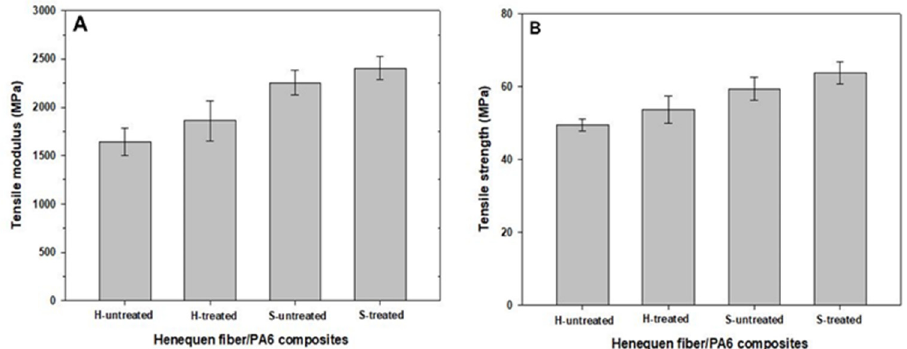
Figure 9. Tensile modulus ( A ) and strength ( B ) of untreated and alkali-treated henequen fiber/PA6 composites produced via different fiber feeding routes.